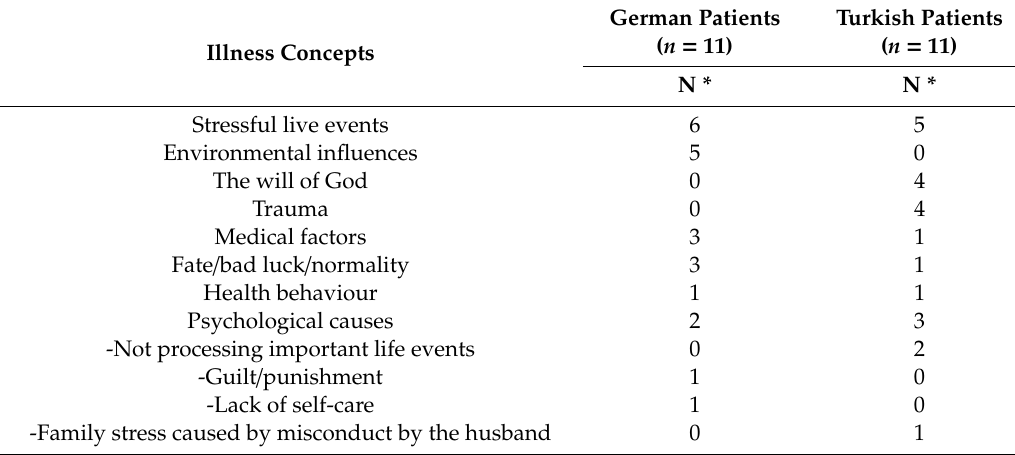
Table 2. Illness concepts of German and Turkish cancer